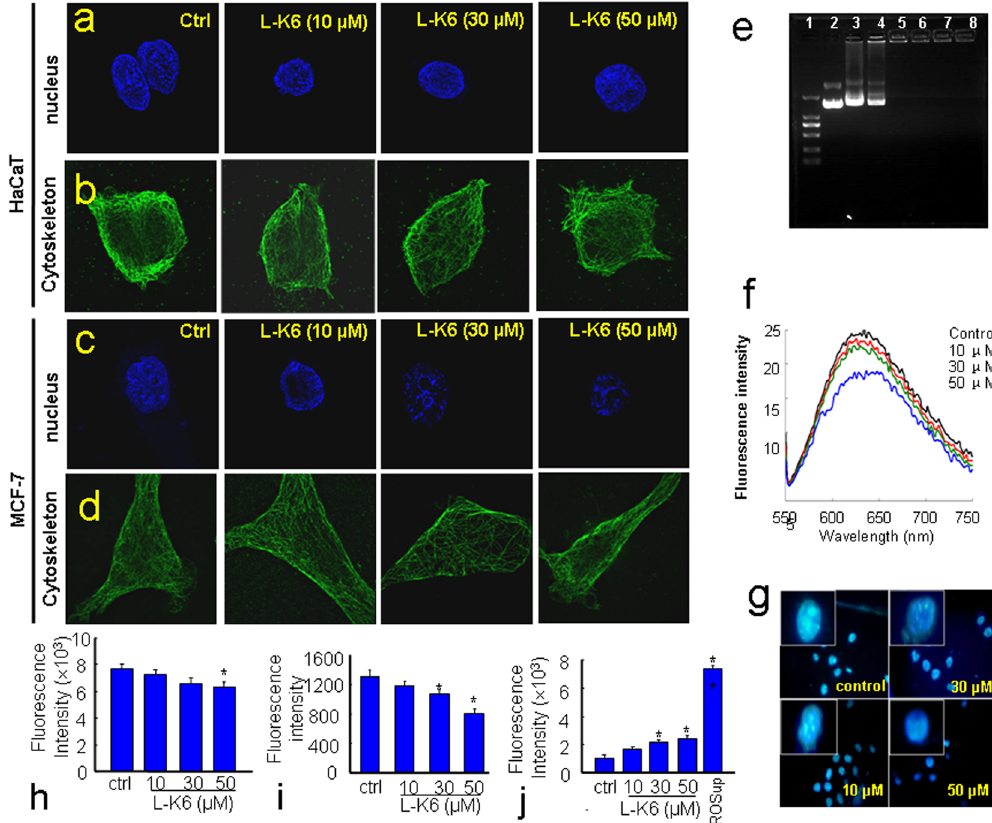
Figure 7. L-K6-induced nuclear damage in MCF-7 cells. The data from super-resolution microscopy observation clearly revealed that the cytoskeleton and nucleus of the HaCaT cells remained intact after L-K6 exposure ( a , b ). In contrast, L-K6 exposure induced significant nuclear damage in the MCF-7 cells, as indicated by the diminished blue fluorescence ( c ), without significant interruption of the cytoskeleton ( d ). Moreover, the DNA binding activity of L-K6 was evaluated using an electrophoretic gel mobility shift assay. (1) λ -Hind III digested DNA Marker; (2–8) the peptide:DNA mass ratios are 0:1, 0.5:1, 1:1, 5:1, 10:1, 50:1 and 100:1, respectively ( e ). The fluorescence spectra were measured from 550 to 750 nm (Ex 535 nm). When the concentrations of L-K6 increased, the fluorescence of the EB–DNA system decreased ( f ). A one-hour treatment with L-K6 consistently resulted in a dose-dependent reduction of DAPI fluorescence brightness in the MCF-7 cells ( g ), which may indicate chromatin decondensation and DNA double strands breaks. FACS analysis was performed to detect the mitochondrial membrane potential, intracellular calcium (Ca 2 + ) levels and ROS production, after a one-hour L-K6 exposure to MCF-7 cells. The data indicated that after one hour of treatment, L-K6 induced only a slight reduction of the mitochondrial membrane potential ( h ). The cytosolic Ca 2 + level was also slightly decreased at higher concentrations ( i ). In addition, ROS production was also elevated after one hour of L-K6 exposure ( j ). * p < 0.05, ** p < 0.01 vs. untreated control group. All experiments had been performed in